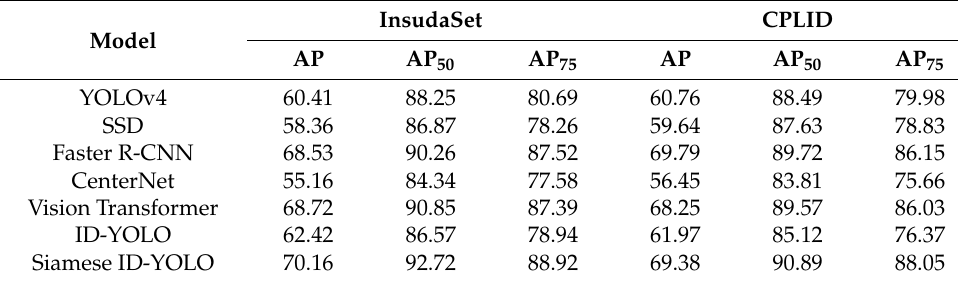
Table 4. Comparison accuracy and speed table of different models.